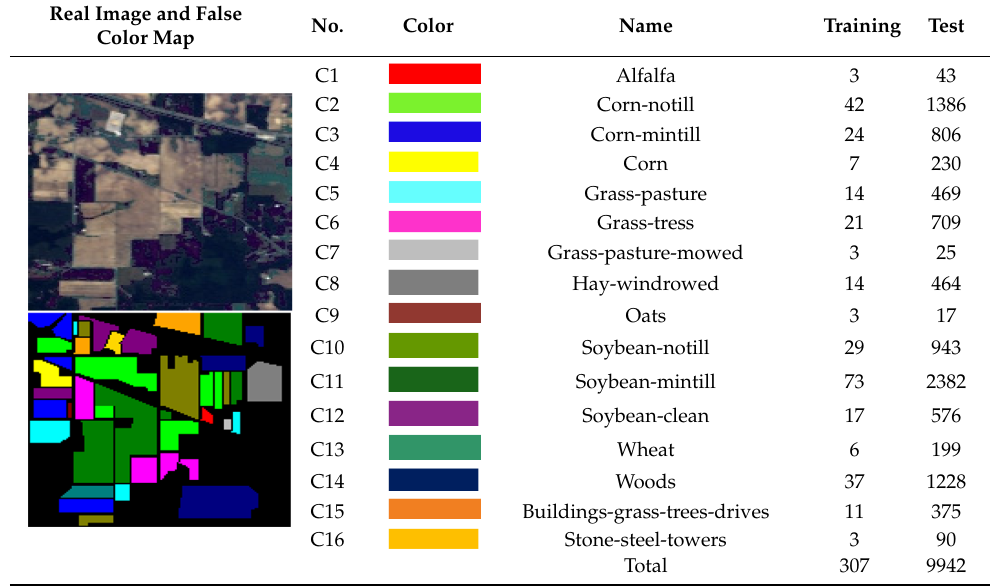
Table 1. Real image, false color map, and number of samples available in the Indian pines (IN) dataset. Real Image and False Color Map